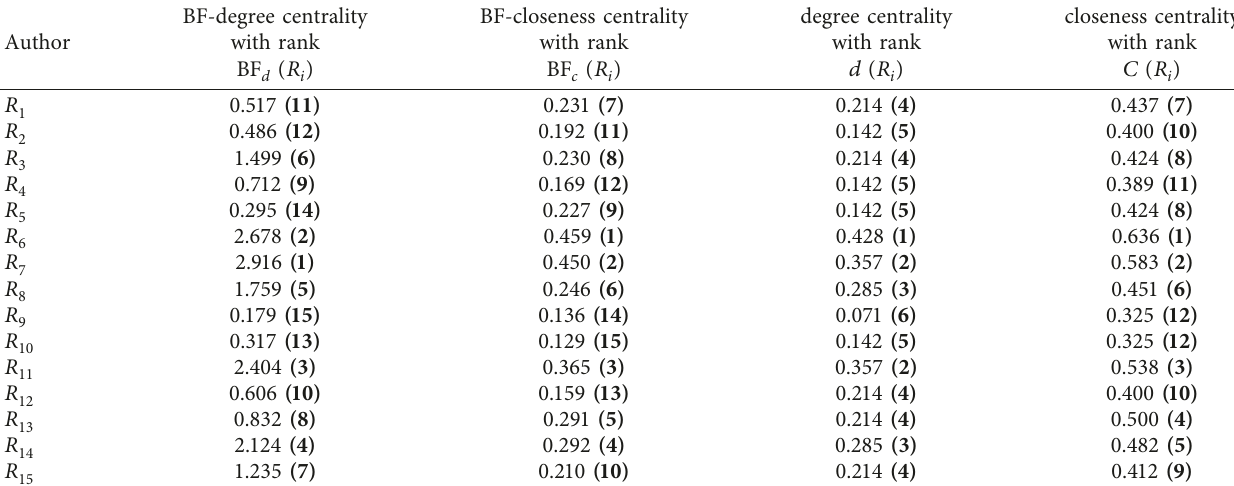
Table 6: BF-degree centrality, BF-closeness centrality, degree centrality, and closeness centrality with ranking of authors. Author